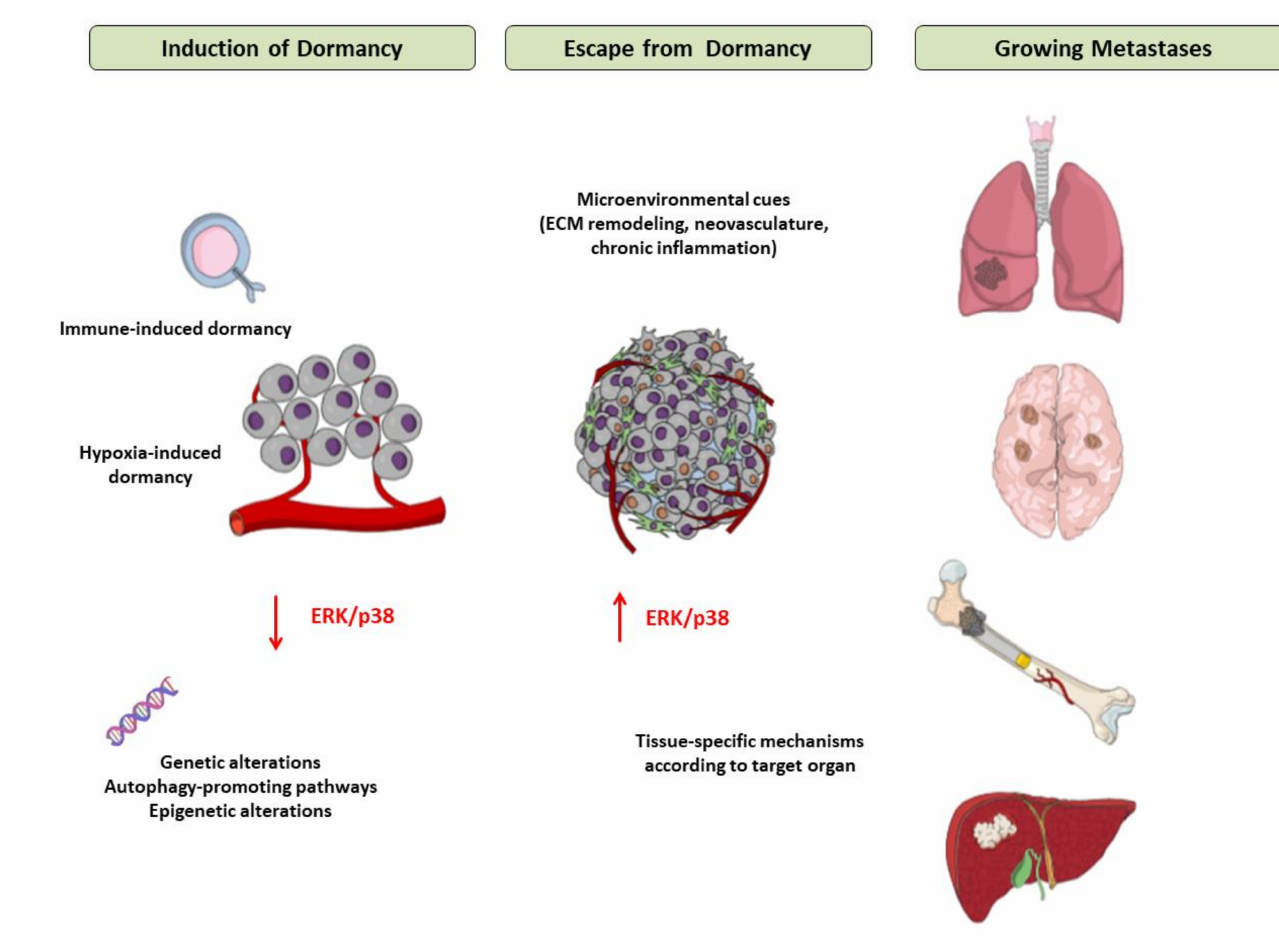
Figure 2. Mechanisms of induction of and escape from tumor dormancy. Tumor cells, when confronting a hostile environ- ment, may enter a dormant state due to the interactions of extracellular factors (mainly hypoxia and immune cytotoxicity) and intracellular pathways. In response to signals that are not fully elucidated yet but appear to involve modifications of tumor microenvironment, such as extracellular matrix remodeling, neovascularization, chronic inflammation and tissue- specific mechanisms in each metastatic site, tumor cells escape from dormancy, start to proliferate and ultimately form macroscopic metastases in target organs. Abbreviations: ECM = Extracellular Matrix, ERK = Extracellular signalregulated